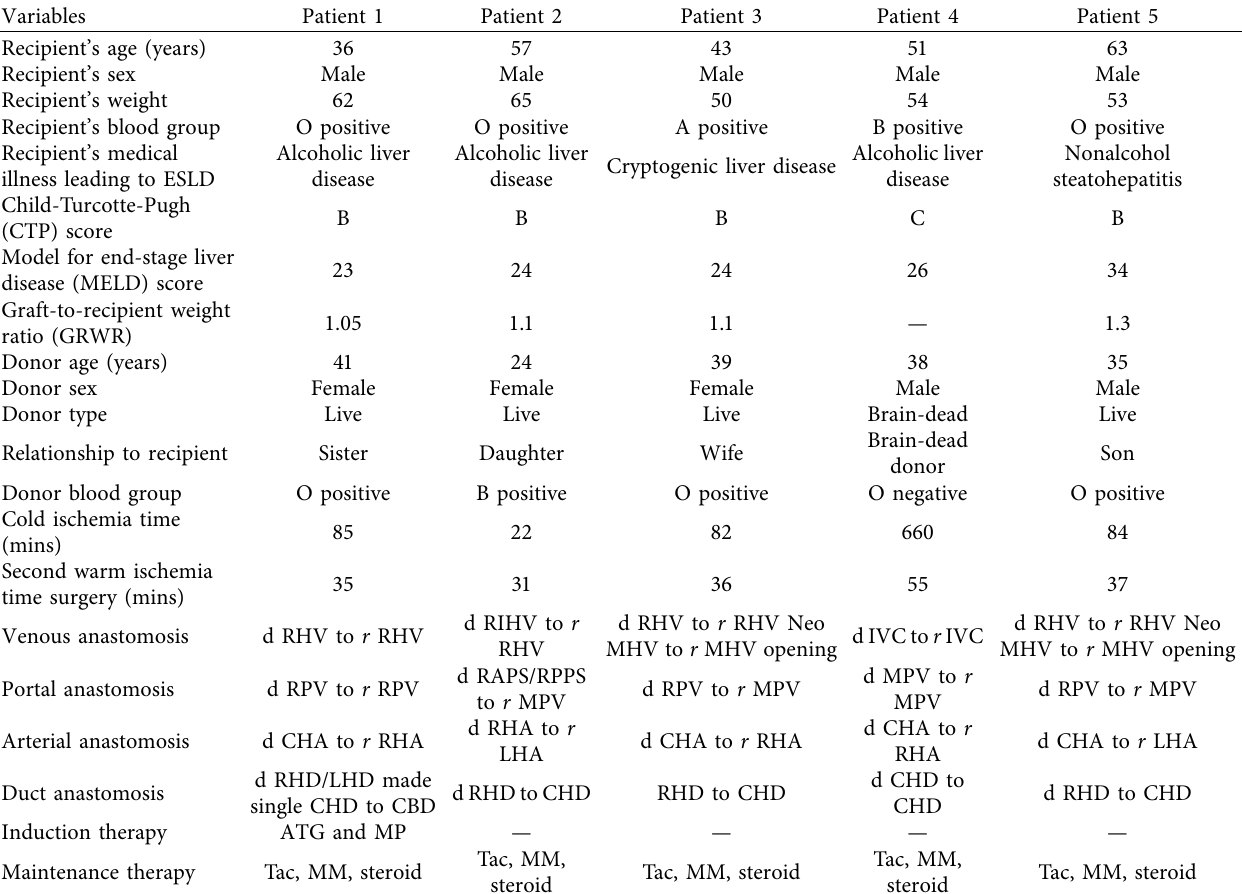
Table 1: Patient’s demographics and perioperative data.